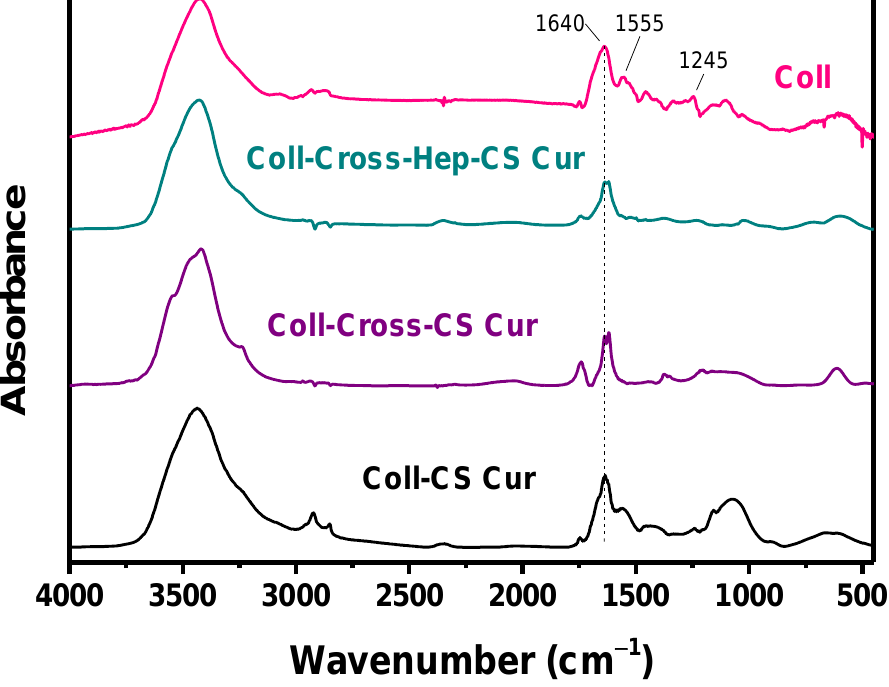
Figure 5. FTIR spectra of collagen patches with CS-NPs.